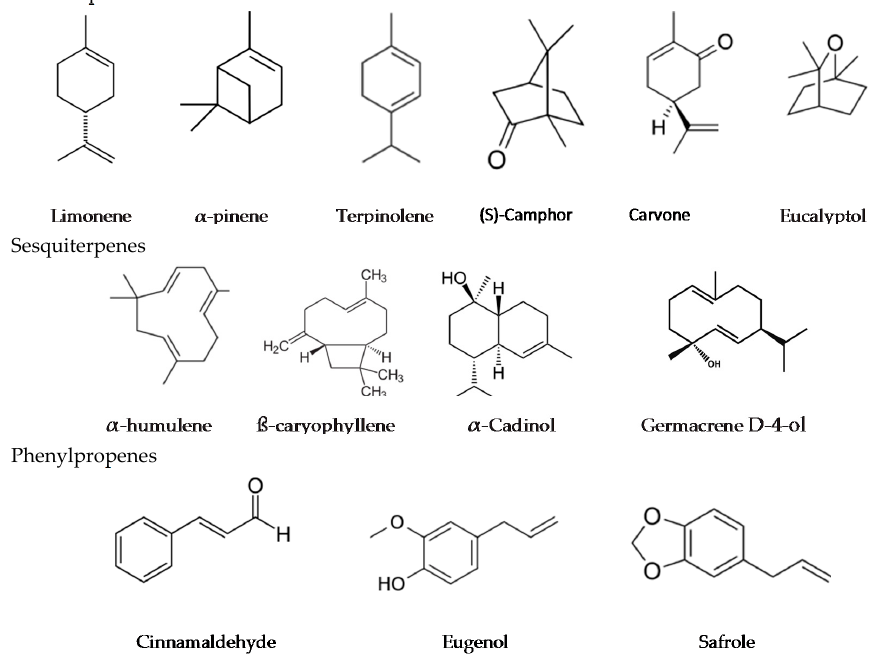
Figure 1. Structural formulae of selected essential oil components.